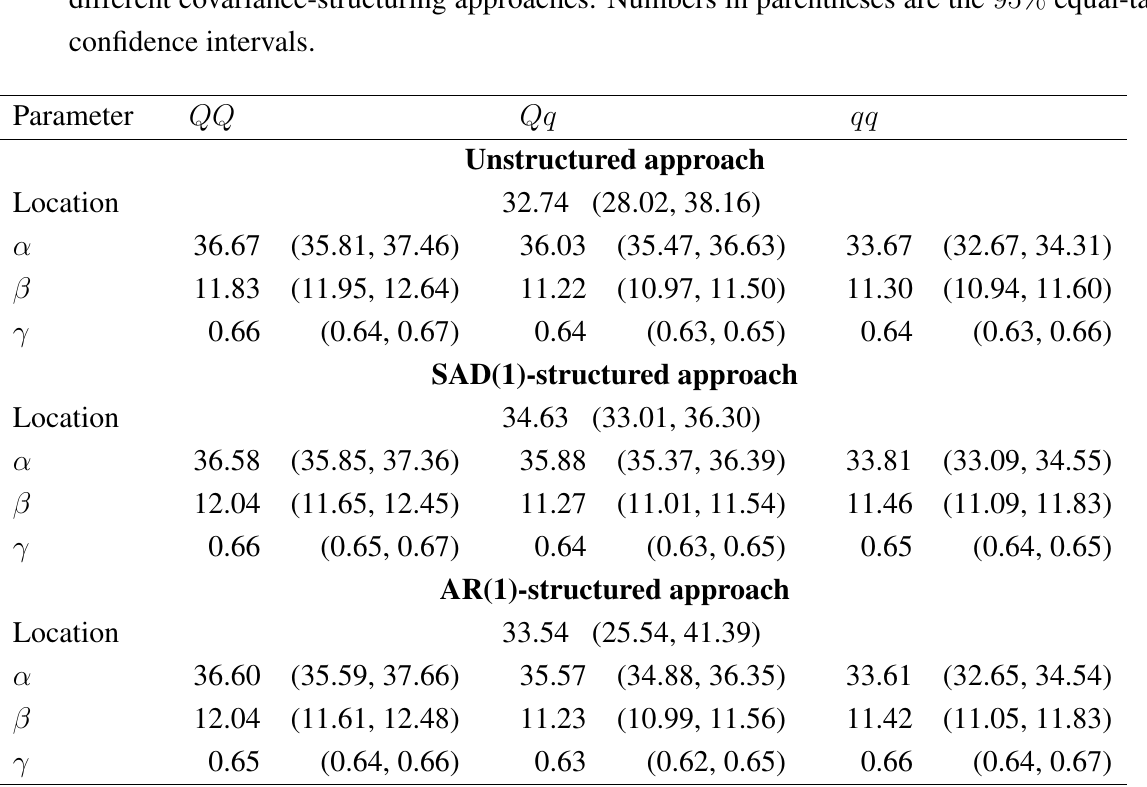
population of 450 individuals based on 2